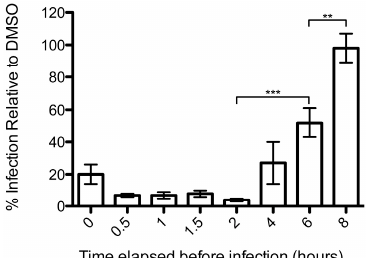
Figure 5. Podofilox’s effect on CMV infection is reversible. MRC5 cells pretreated with 50 nM podofilox were infected with AD169 IE2-YFP and analyzed for fluorescent intensity at 18 h p.i. to determine the number of virus-infected cells. The percentage infection was normalized to cells receiving DMSO pretreatment as 100%. Columns represent average of six replicates and error bars correspond to standard error. ** p < 0.01, *** p <